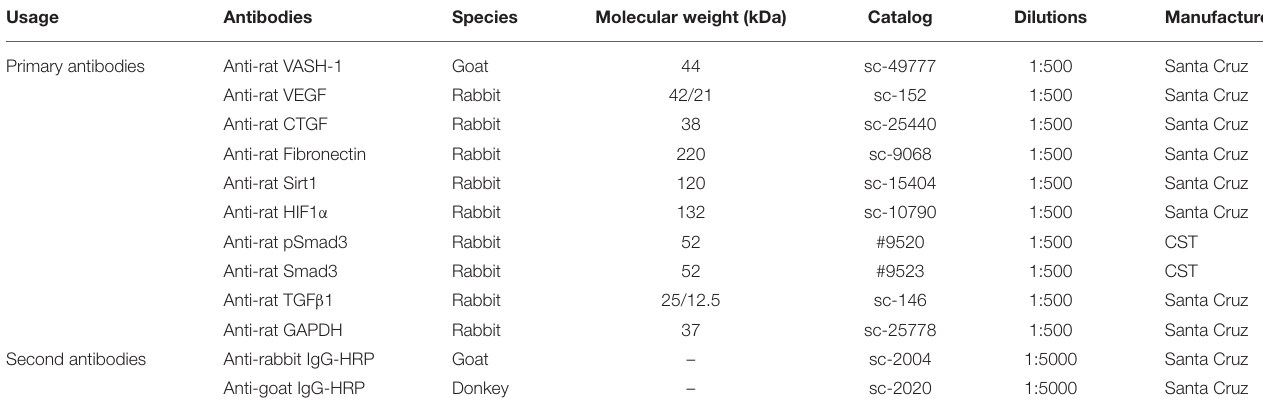
TABLE 3 | Western Blot Antibody